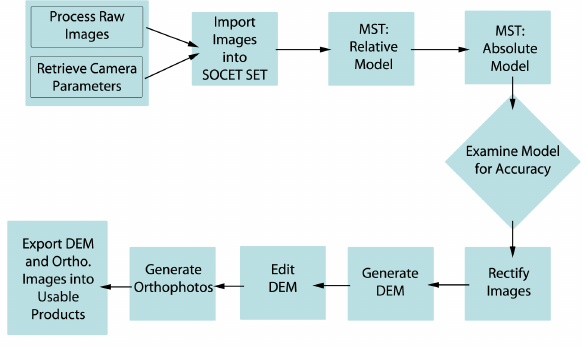
Figure 4. Workflow diagram for DEM production. Orthorectified images are created upon completion of the DEM using SOCET SET’s Orthophoto Generation. Orthophotos are images that have had all distortion due to camera obliquity and terrain relief removed. An orthophoto represents what you would see if you were looking at the ground orthogonally from a hill shade image, color shaded relief image, slope map, and confidence map are provided in GeoTIFF format. These products are made using the Geospatial Data Abstraction Library (GDAL) (Warmerdam 2008).